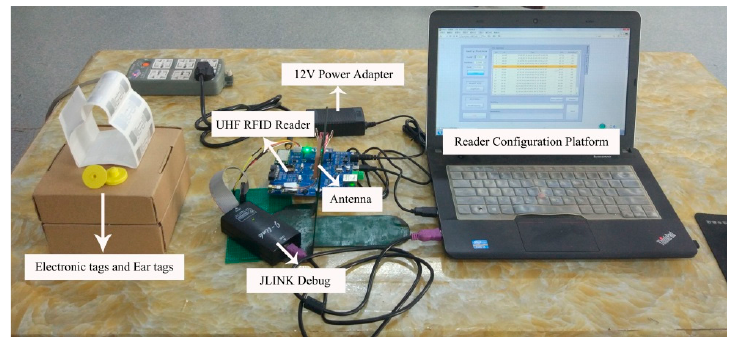
Figure 15. System test